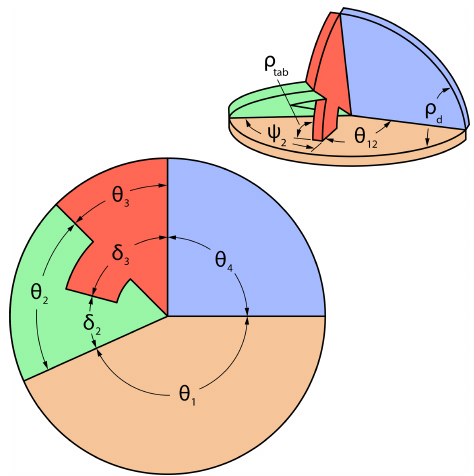
Figure 22. General diagram for a tabbed sector panel ThUDS with key parameters shown.